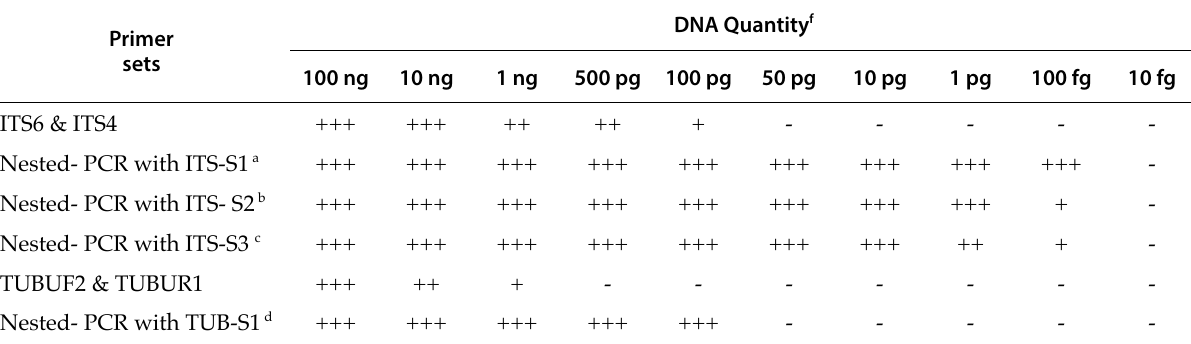
Table 7 . The effect of DNA quantity (per μL sample) on nested-PCR product band density of the putative species-specific primers for Phytophthora pistaciae . Primer sets